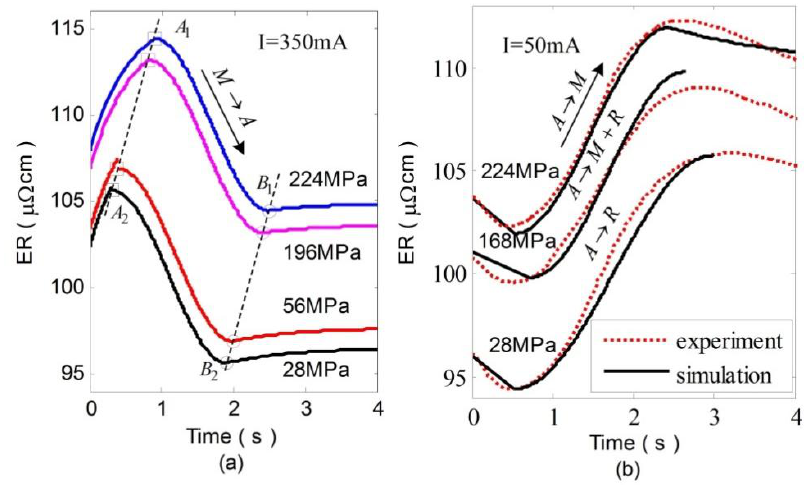
Figure 7. Simulation of ER changes of SMA during heating ( a ) and cooling ( b ) at various